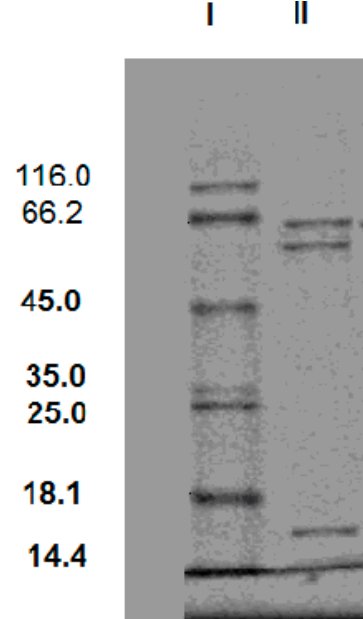
Figure 3. SDS-PAGE of the purification product from the T. virens ZY-01 cultivation broth. Lane I: protein ladder ( β -galactosidase 116.0 kDa, bovine serum albumin 66.2 kDa, ovalbumin 45.0 kDa, lactate dehydrogenase 35.0 kDa, REase Bsp981 25.0 kDa, β -lactoglobulin 18.1 kDa, lysozyme 14.4 kDa), Lane II: purification product.